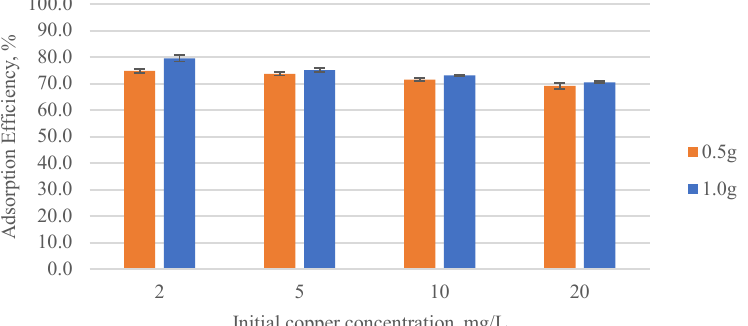
Fig. 4. Adsorption efficiency for copper (II) ions on modified wheat bran as a function of initial copper concentration, n = 3, ±SD.